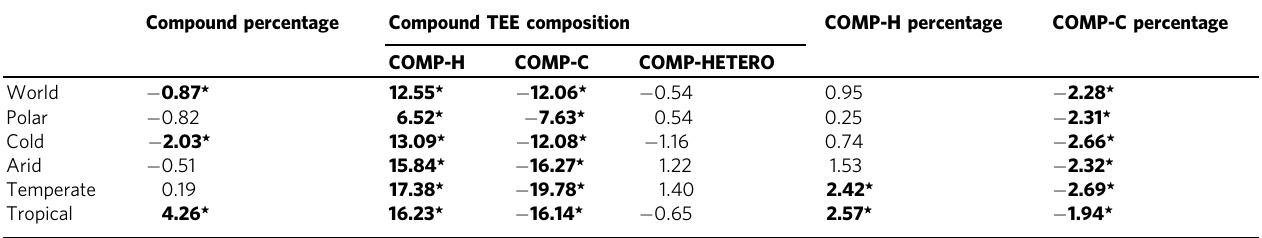
Table 2 Global and regional trends of compound temperature extreme event (TEE) percentage and